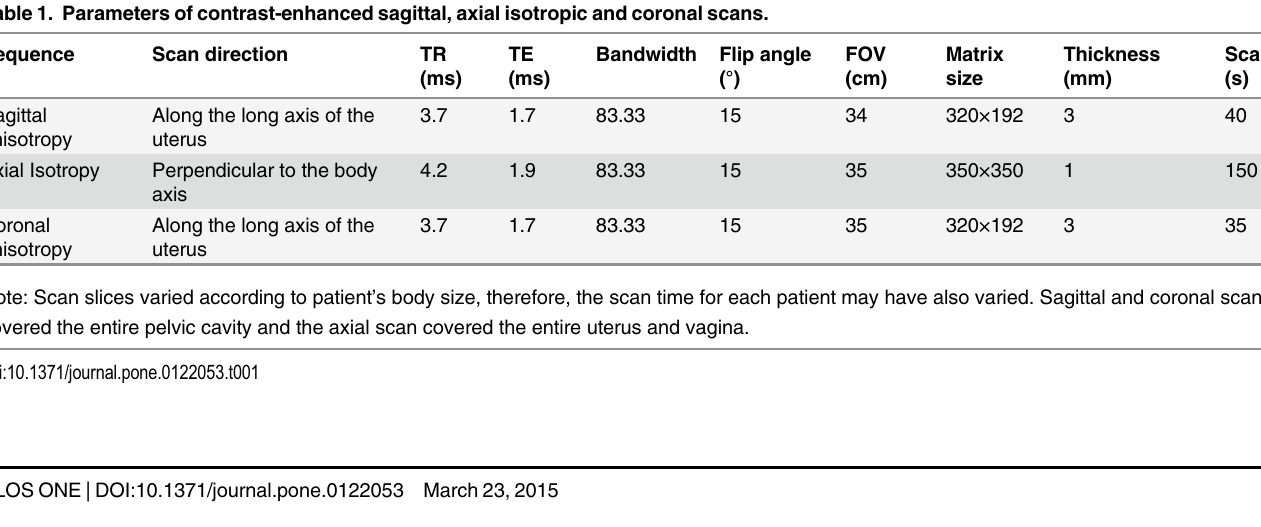
Table 1. Parameters of contrast-enhanced sagittal, axial isotropic and coronal scans. Sequence Along the long axis of the uterus